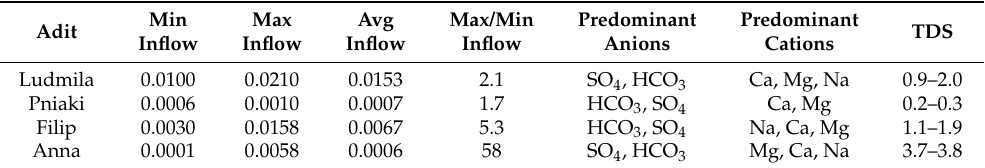
Table 5. Characteristics of groundwater outflows from mine workings through adits (inflow in m 3 /s; TDS in g/L) [44].